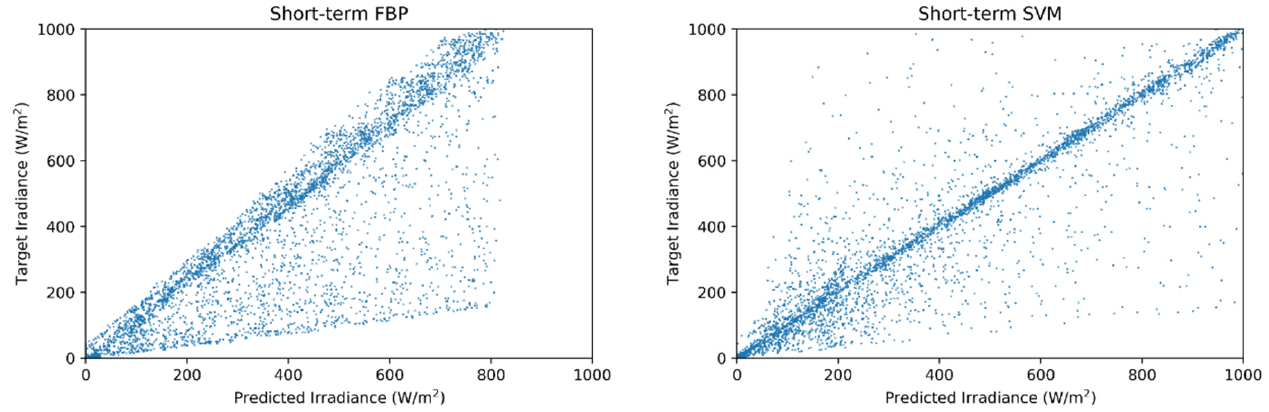
Figure 11. Short-term FBP, SVM predicted, and target values: 1 h ahead.